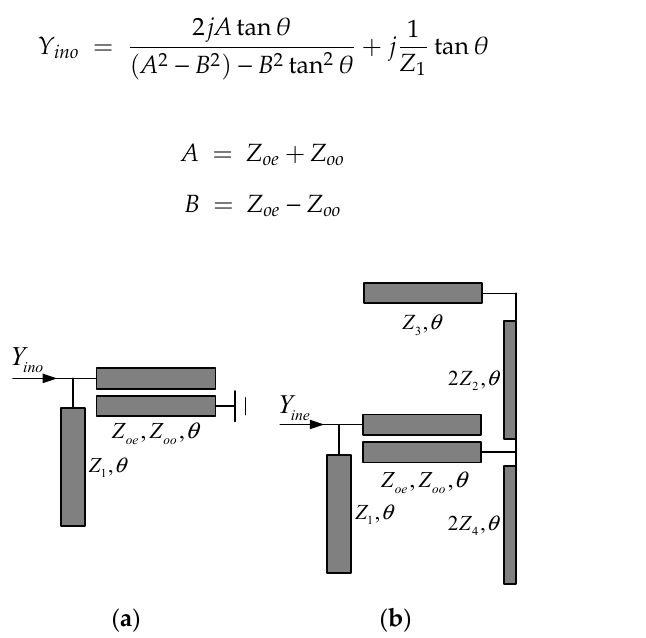
= θ + θ θ = θ + θ L R 1 2 , 1 3 ).